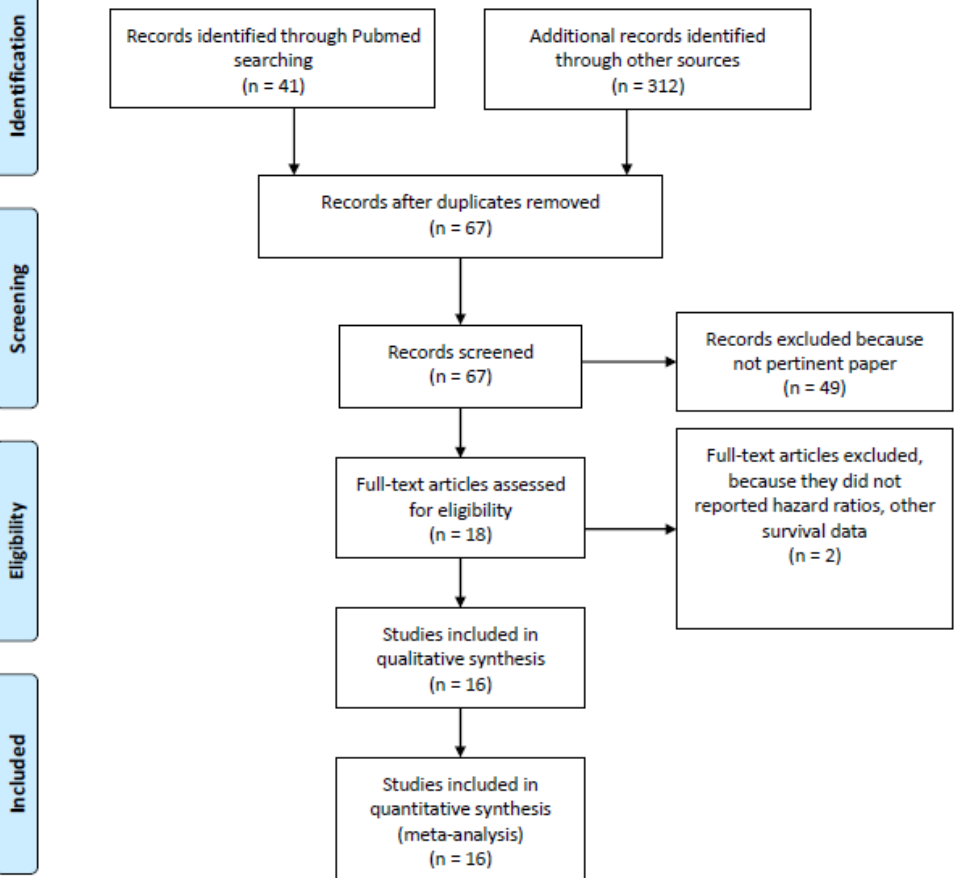
Figure 1. Flow diagram of included studies.